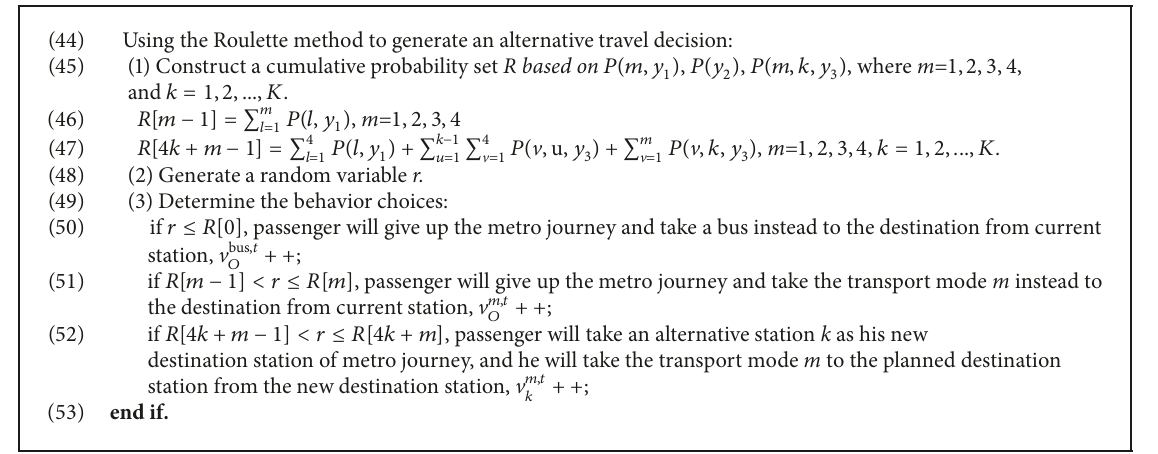
Algorithm 1: Solution algorithm of the passenger behavior model.